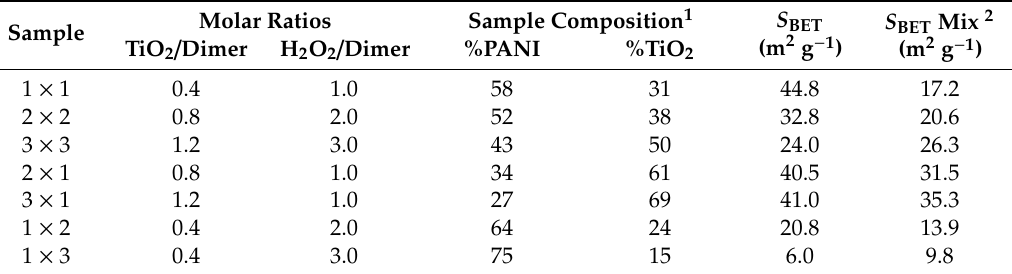
Table 1. Stoichiometric molar ratios of photocatalyst and H 2 O 2 with respect to aniline dimer (columns 2 and 3), weight percentage of PANI and TiO 2 in the final products obtained from TG analyses (columns 4 and 5), measured specific surface area of each composite and calculated surface area of a physical mixture with same composition (columns 6 and